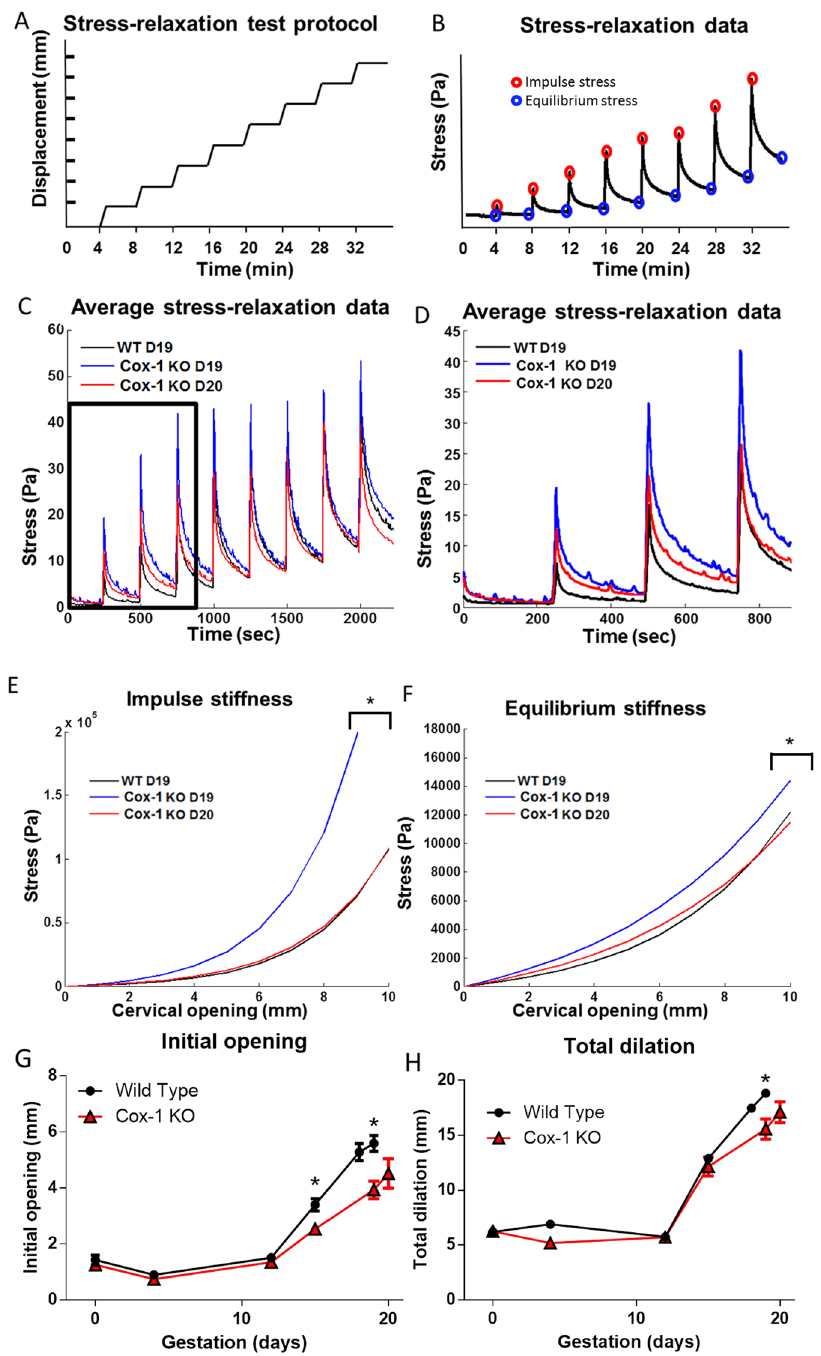
Figure 5. Cox-1 KO mice have less distensible cervices at term than WT. ( A ) Displacement protocol used for biomechanical stress relaxation tests. ( B ) Representative data from stress-relaxation biomechanical tests. Red circles highlight the maximum impulse stress observed for each displacement; blue circles highlight the equilibrium stress observed four minutes post displacement. ( C ) Average stress-relaxation recordings from WT day 19, Cox-1 KO day 19, and Cox-1 day 20 cervical tissues. ( D ) Inset of the average stress- relaxation data from the first three displacements. ( E , F ) Average exponential fits to the impulse stiffness and equilibrium stiffness results from WT day 19, Cox-1 KO day 19, and Cox-1 KO day 20 cervical tissues, * p < 0.05 compared to day 19 WT. ( G ) Unloaded dilation of ex vivo cervical tissues from WT and Cox-1 KO mice across gestation (n = 8–10 per group, per time point). ( H ) Total dilation of ex vivo cervical tissues prior to tissue